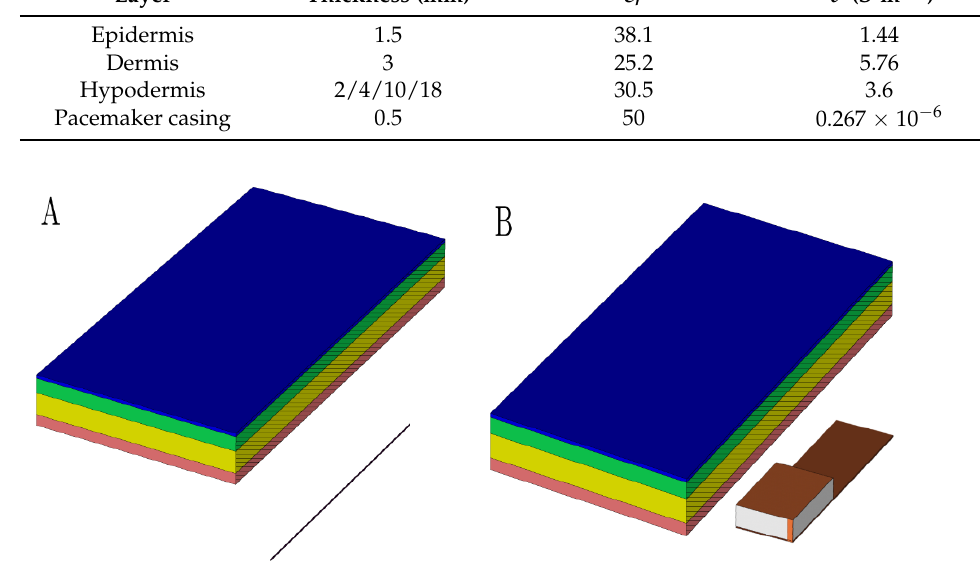
Figure 5. The geometrical layout of a used multilayered model with a dipole antenna ( A ) and PIFA antenna ( B ) model. The perspective view with vertical cutting plane crossing the longitudinal axis of the antenna was used to emphasize the mutual distance between the antenna and dermis. It was set up to 10 mm. Pink colored block is an epidermis layer, yellow block is a dermis layer, green block is a hypodermis layer, and blue block is a pacemaker